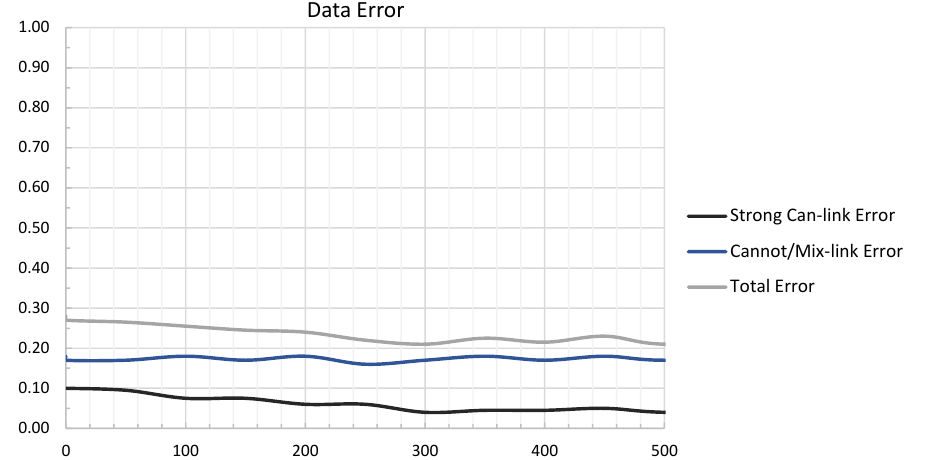
Figure 7. The figure illustrates the erroneous data ratio passed to the model while training. The horizontal and vertical axis represents epochs and error ratio, respectively. Table 3. Comparison of different models. The best results are marked in